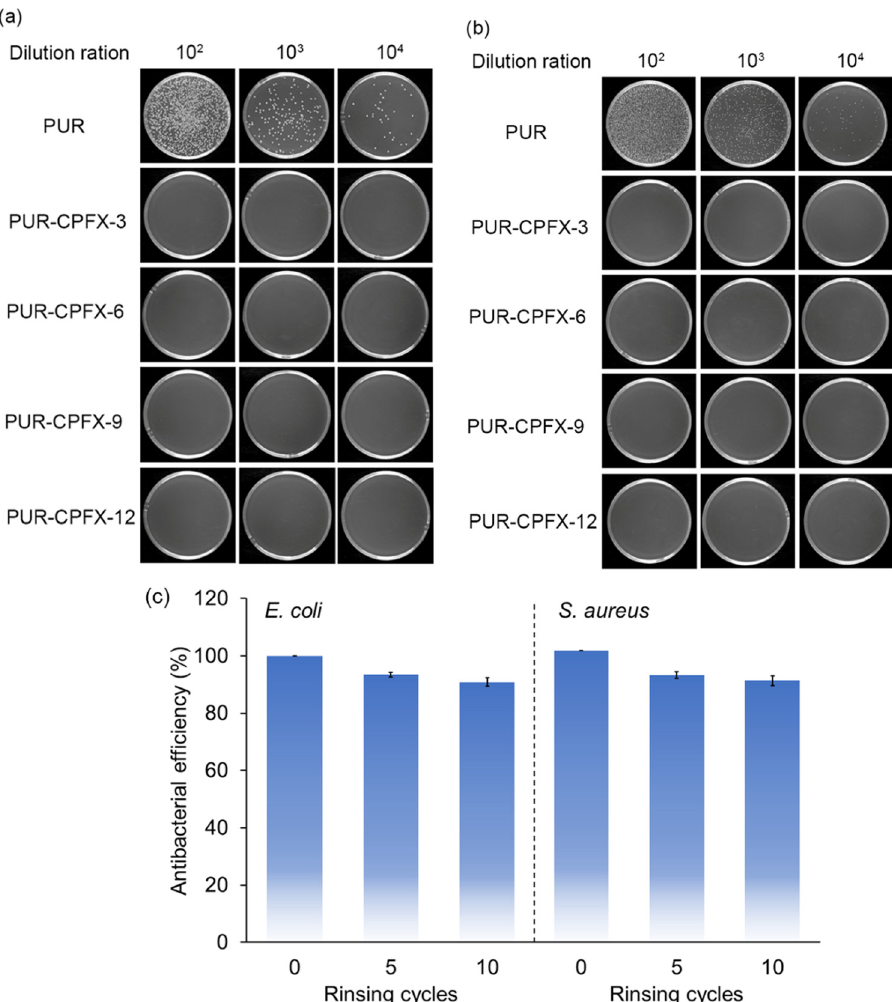
Figure 4: Antibacterial activity against ( a ) E. coli and ( b ) S. aureus of leather retanned by PUR and PUR - CPFXs. ( c ) Antibacterial e ffi ciency against E. coli and S. aureus vs rinsing